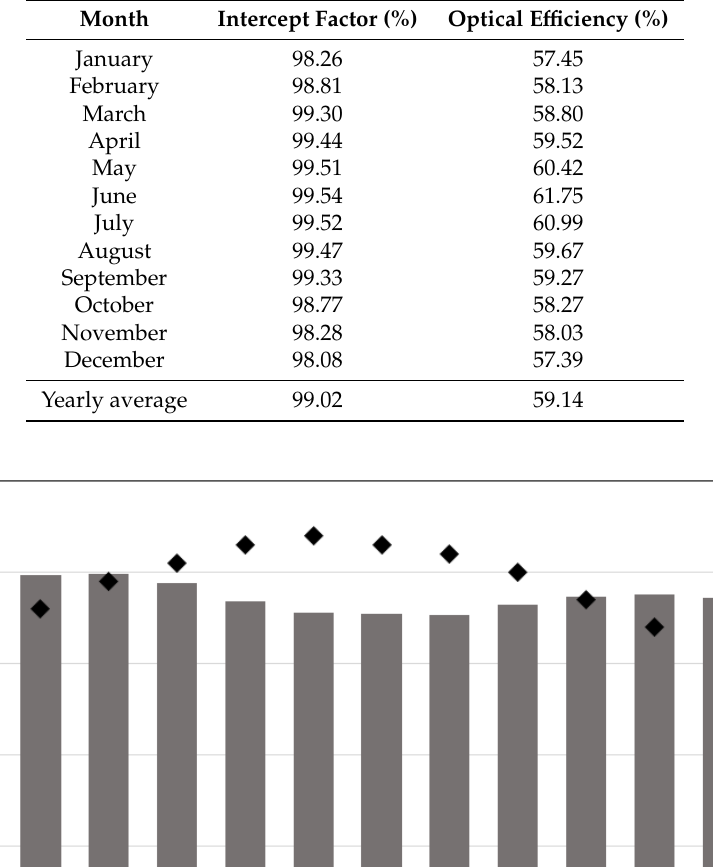
Table 3. Monthly averaged intercept factors and optical e ffi ciency of the field.